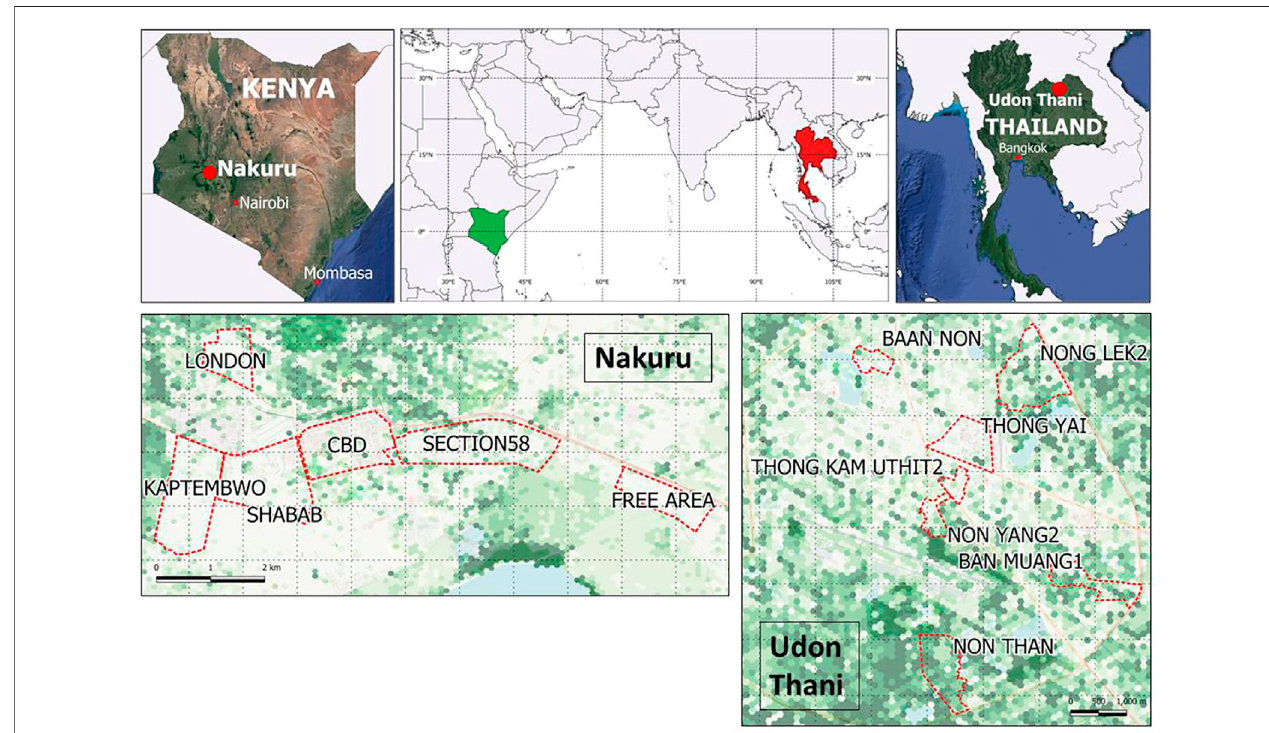
FIGURE1| casestudycitylocationsandsurveyedneighbourhoods.Basemapsindicate100 mwidthhexedgridrelativegreennessderivedfromLandsatimagery processed to show Normalised Difference Vegetation Index (NDVI).